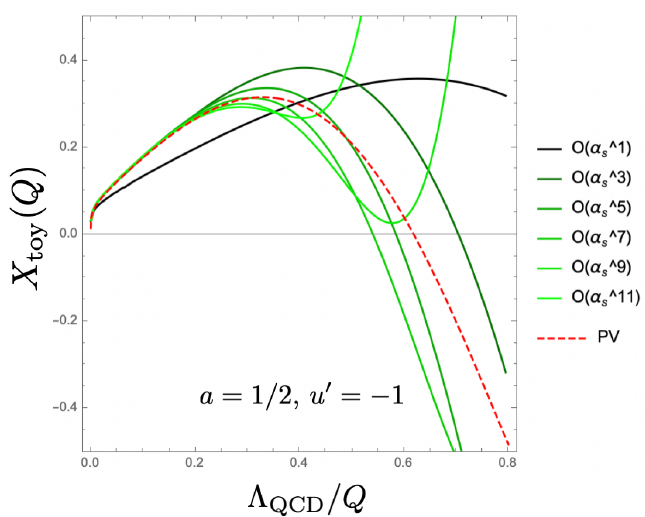
Figure 3 . Comparison of PV prescription (dashed red line) and FTRS method (green lines with gradation) for X toy ( Q ) . We set b 0 = 1 . The parameters of the Fourier transform are adjusted to a = 1 / 2 and u 0 = − 1 such that the u = 2 renormalon remains unsuppressed. The momentum-space series is truncated at order α s ( τ ) k ( k = 1 , · · · , 11